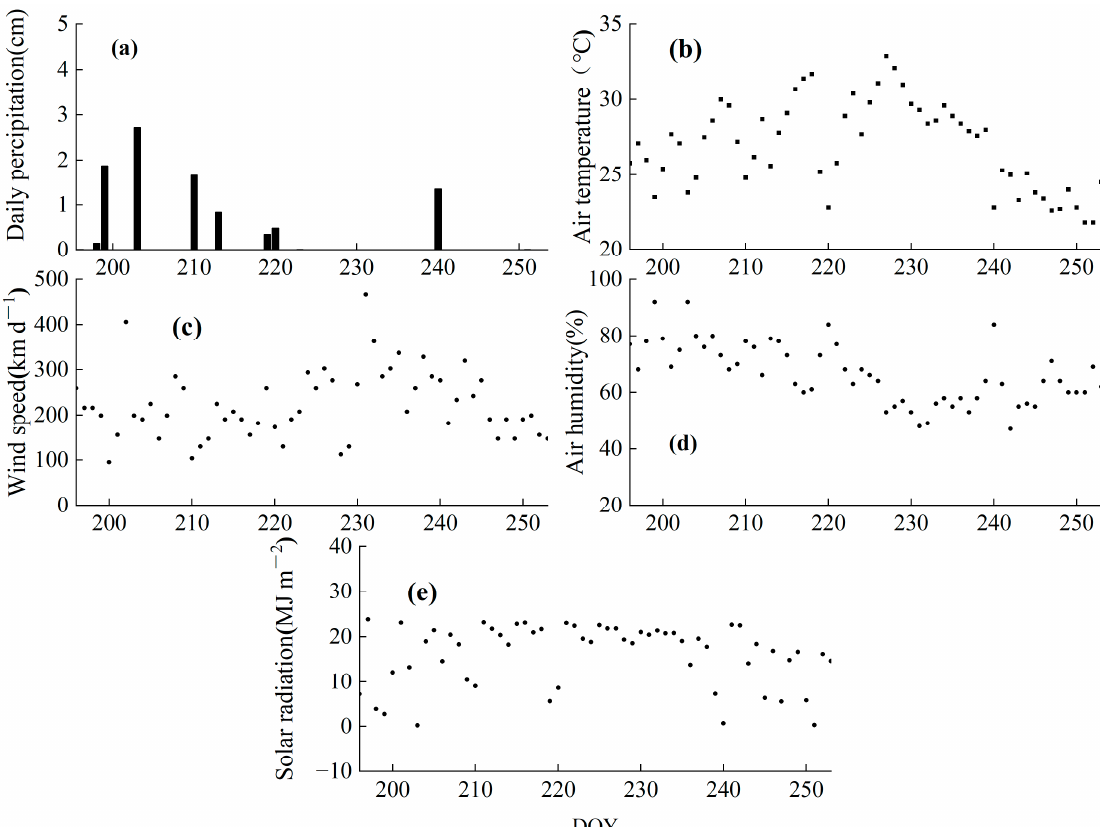
Figure 2. Meteorological data during the study period. ( a ) daily precipitation; ( b ) air temperature; ( c ) wind speed; ( d ) air humidity; ( e ) solar radiation. Table 1. Soil’s physical properties.